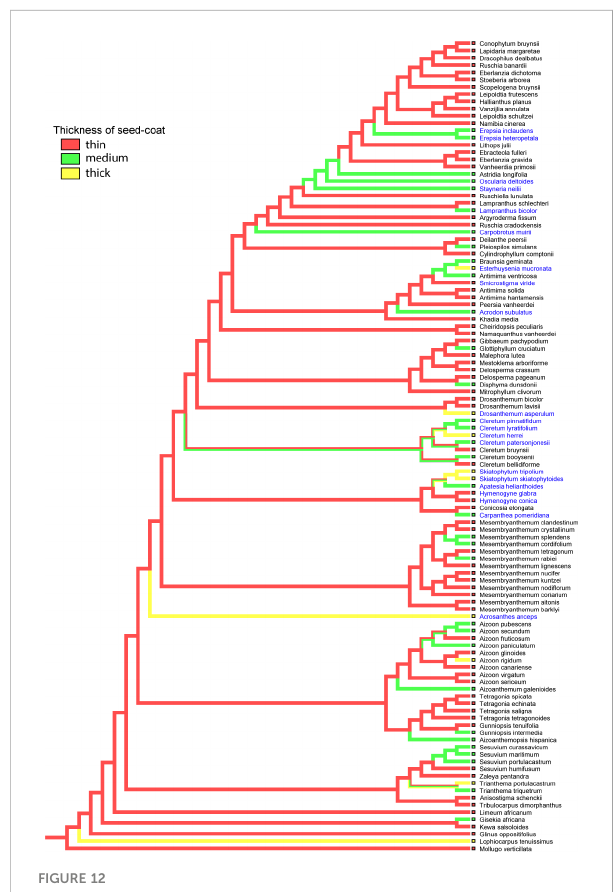
FIGURE 12 Ancestral character reconstruction of thickness of seed coat. Species names highlighted in blue indicate that they are endemic to a fi re prone habitat (either fynbos or renosterveld